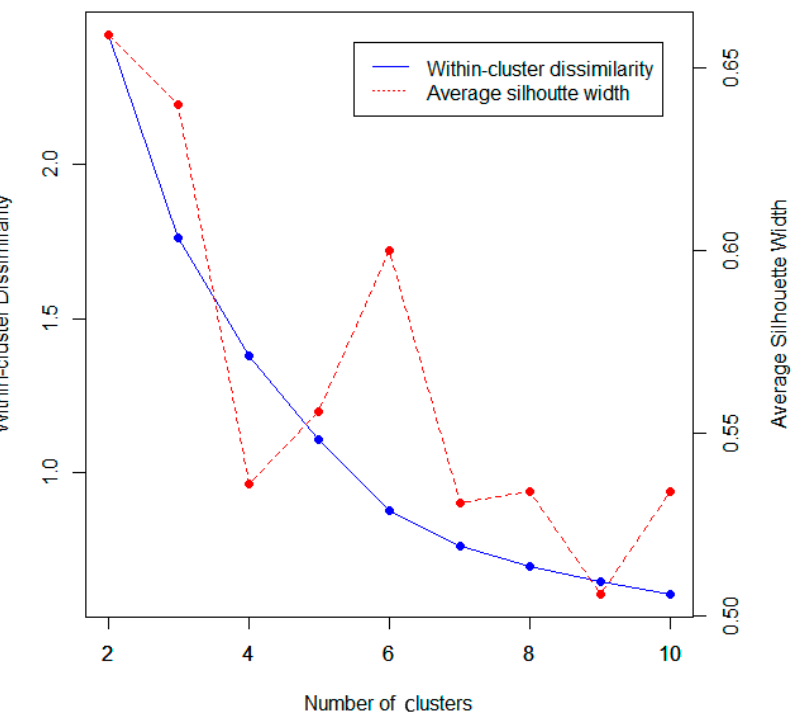
Figure 4. Scree plot of k-means clustering for average within-cluster dissimilarities and average silhouette widths.